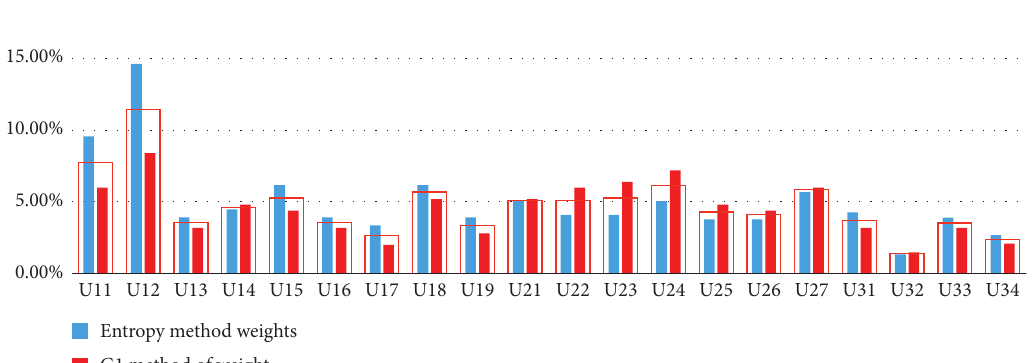
Figure 10: The combined risk weighting for ancient buildings.